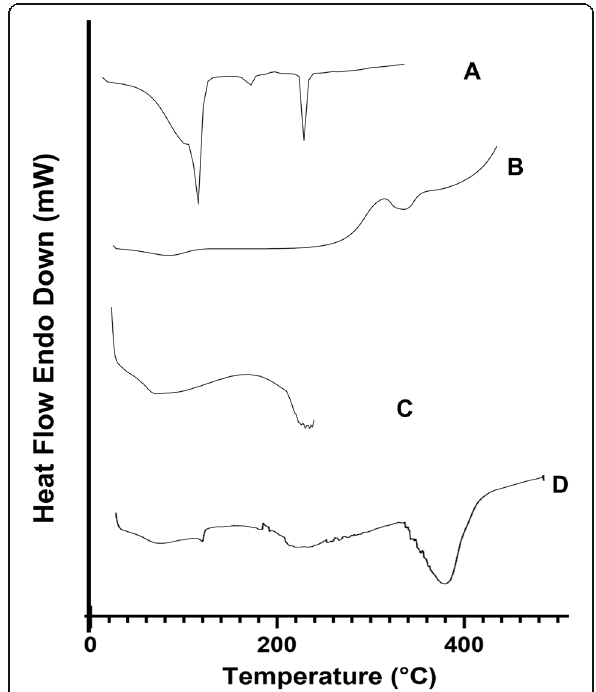
Fig. 2 DSC spectra of ( a ) pure flurbiprofen, ( b ) HPMC K15M, ( c ) ERL100 and ( d ) drug and polymer physical